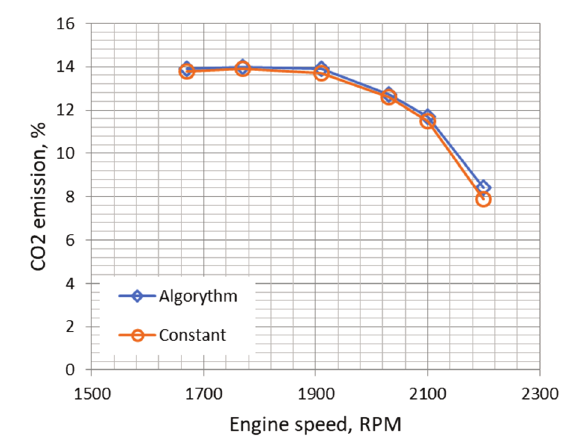
Fig. 13. Relationship between CO 2 emission and rotational speed for constant and variable ignition advance